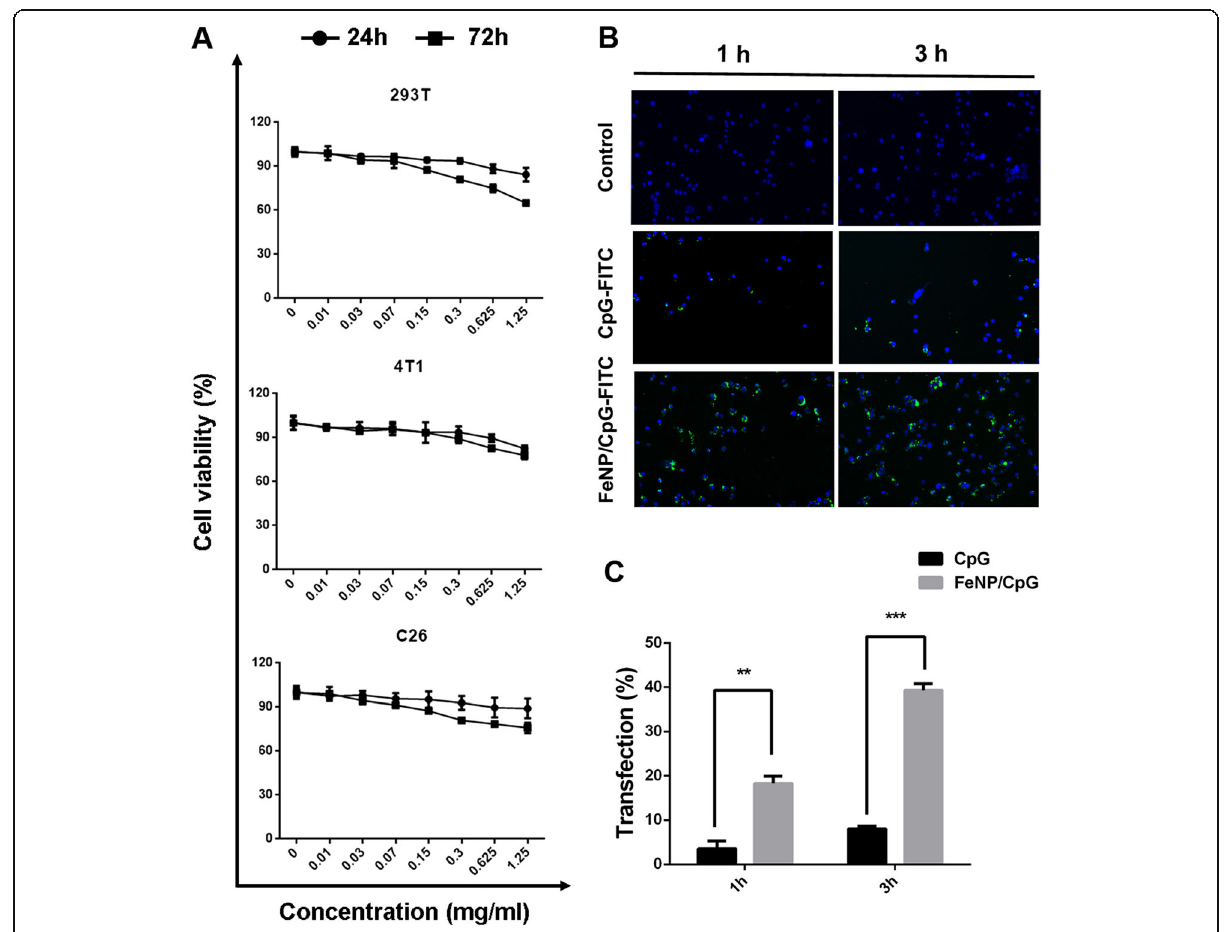
Fig. 3 Cytotoxicity and uptake activity of FeNP/CpG particles in vitro. a MTT assay. We detected the viability of 293T, 4T1, and C26 cells after treatment with various concentrations of FeNP particles for 24 h or 72 h. There was no significant difference in cell viability at any dose of FeNPs. b , c The detection of FeNP/CpG uptake in BMDCs. BMDCs prepared after GM - CSF treatment for 7 days were transfected with CpG-FITC or FeNP-delivered CpG-FITC for 1 or 3 h before being intensively washed, fixed, and labeled with DAPI. Images were captured by laser scanning confocal microscopy (LSCM). Compared with that of free FITC-labeled CpG, the FeNP/CpG with enhanced fluorescence intensity ( b ) and transfection efficiency were statistically significant ( c ). These data were representative of three independent experiments, the mean ± standard error; * P < 0.05, * P < 0.01, and *** P < 0.001 vs the untreated